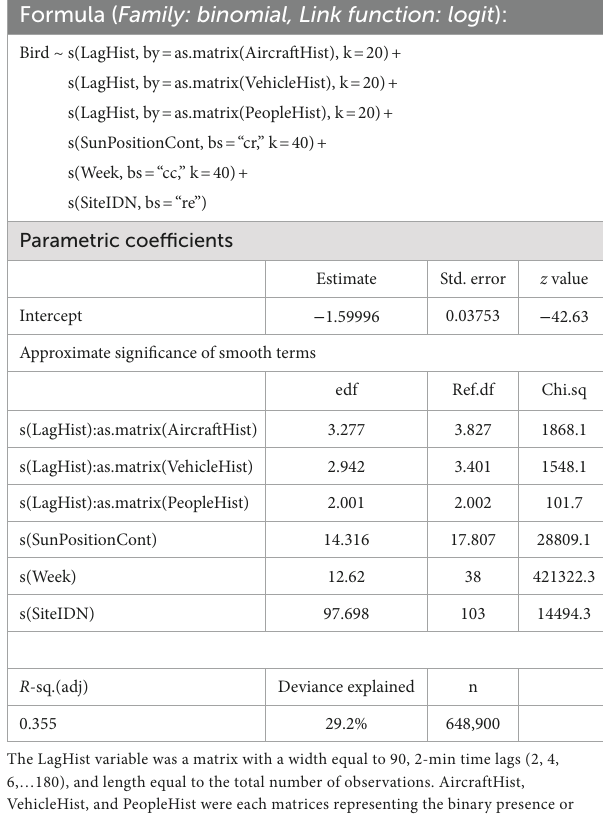
TABLE 1 Summary output for the full general additive model that was fit with data from all park